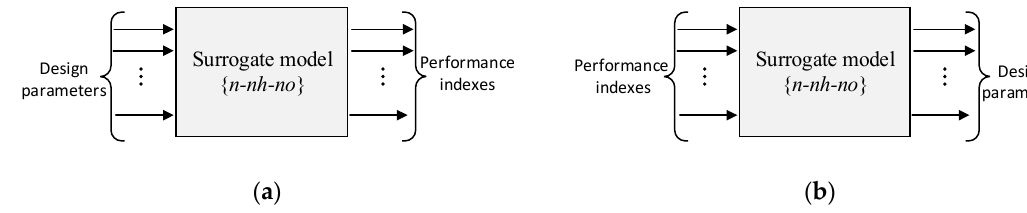
Figure 3. The antenna analysis model ( a ) and synthesis model ( b ).